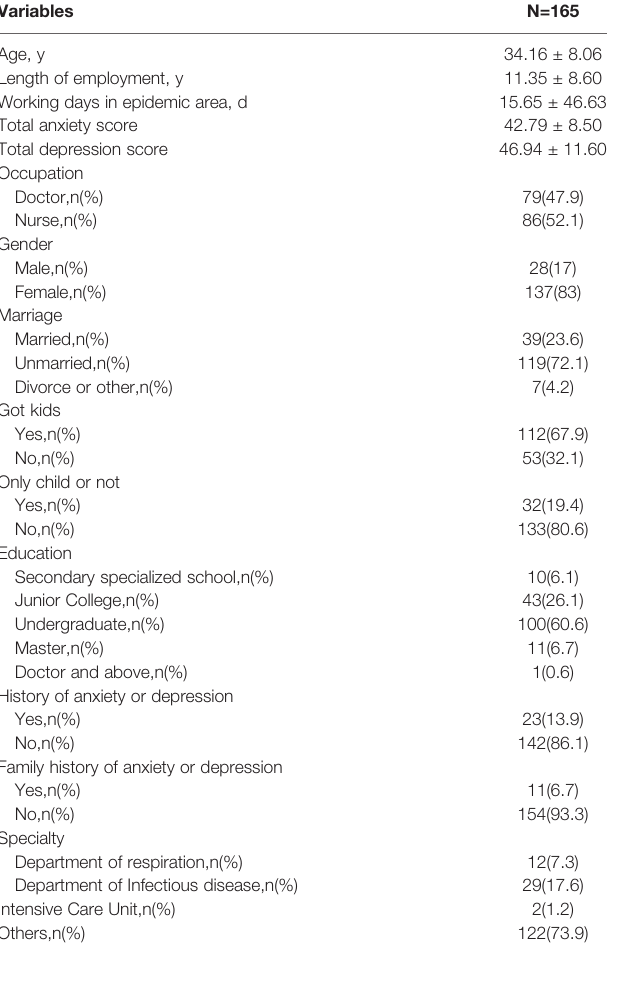
TABLE 1 | General demographic information of medical staff.